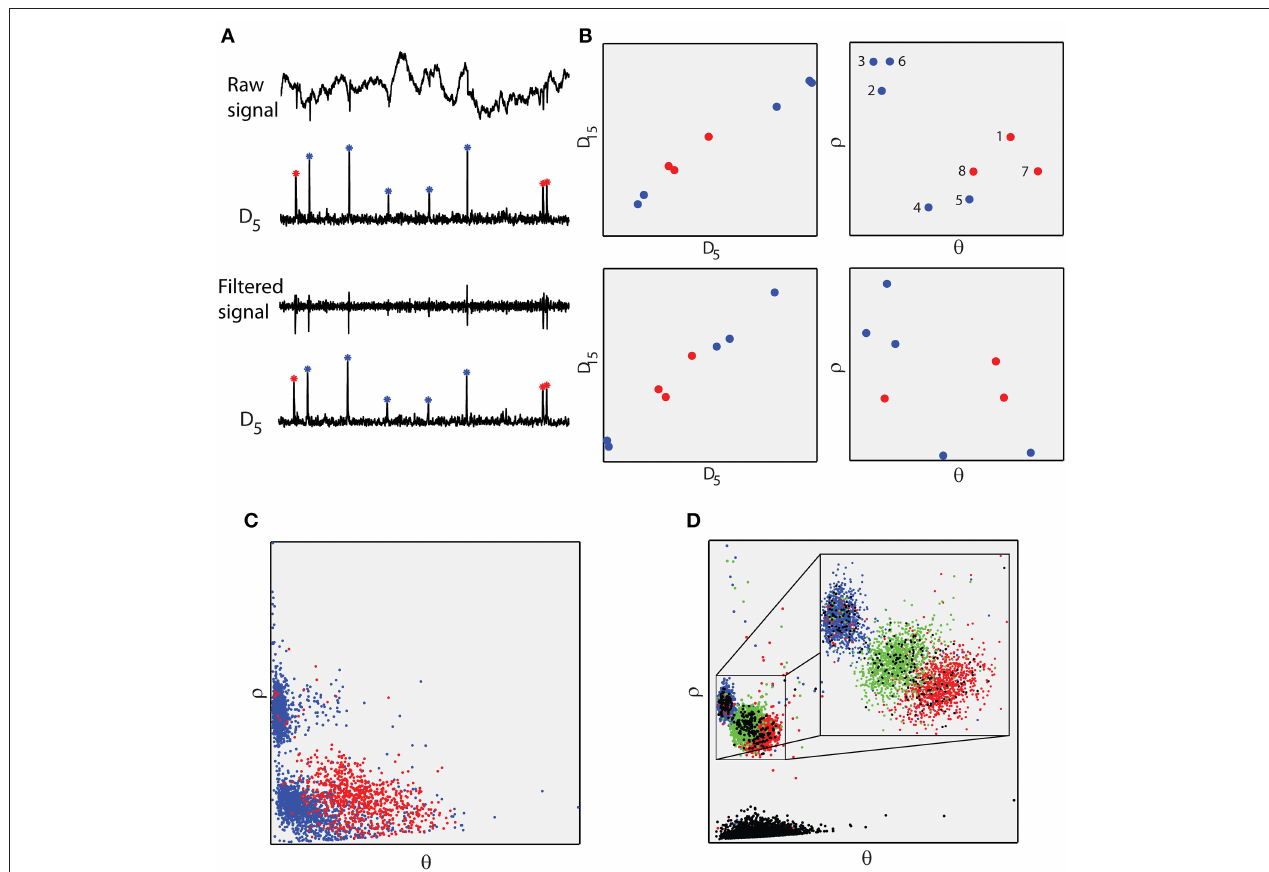
FIGURE 2 | The proposed features. (A) Raw and filtered signal (same as Figure 1 ) and corresponding D 5 signals. Maxima of the D 5 signal correspond to spikes in both the raw and filtered recordings. Red stars correspond to the same neuron ( Henze et al., 2009; intracellularly recorded neuron). Red stars lay approximately in the same amplitude level, different from the blue ones. (B) Left, amplitude of D 15 maxima against amplitude of D 5 maxima, estimated from raw (first row) and filtered (second row) recordings. Right, the corresponding polar coordinates. Polar coordinates of the D 5 and D 15 maxima comprise the proposed feature space. Red dots correspond to red stars in (A) . (C) Feature space for the entire 533101 raw signal. Red dots correspond to the spiking activity of the intracellularly recorded neuron. Blue dots correspond to “noisy” spiking activity. (D) The proposed feature space of dataset 3 in the fourth level of noise from the simulated database (Quiroga et al., 2004 ). Blue, green, and red dots correspond to three different neurons. Black dots correspond to falsely detected